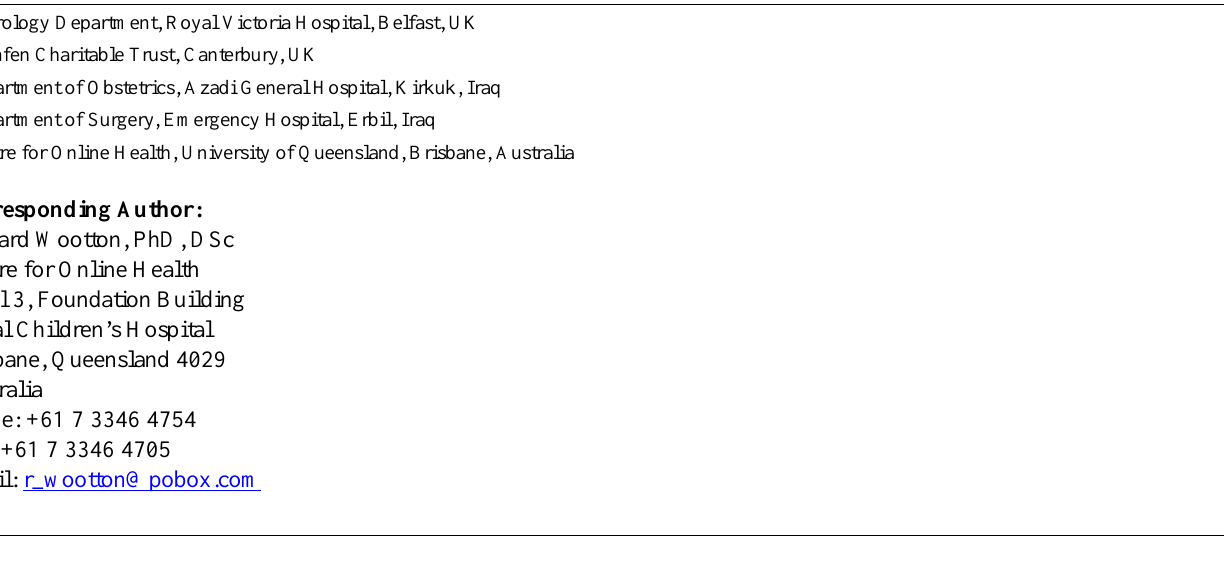
Telemedicine; electronic mail; developing countries; Middle